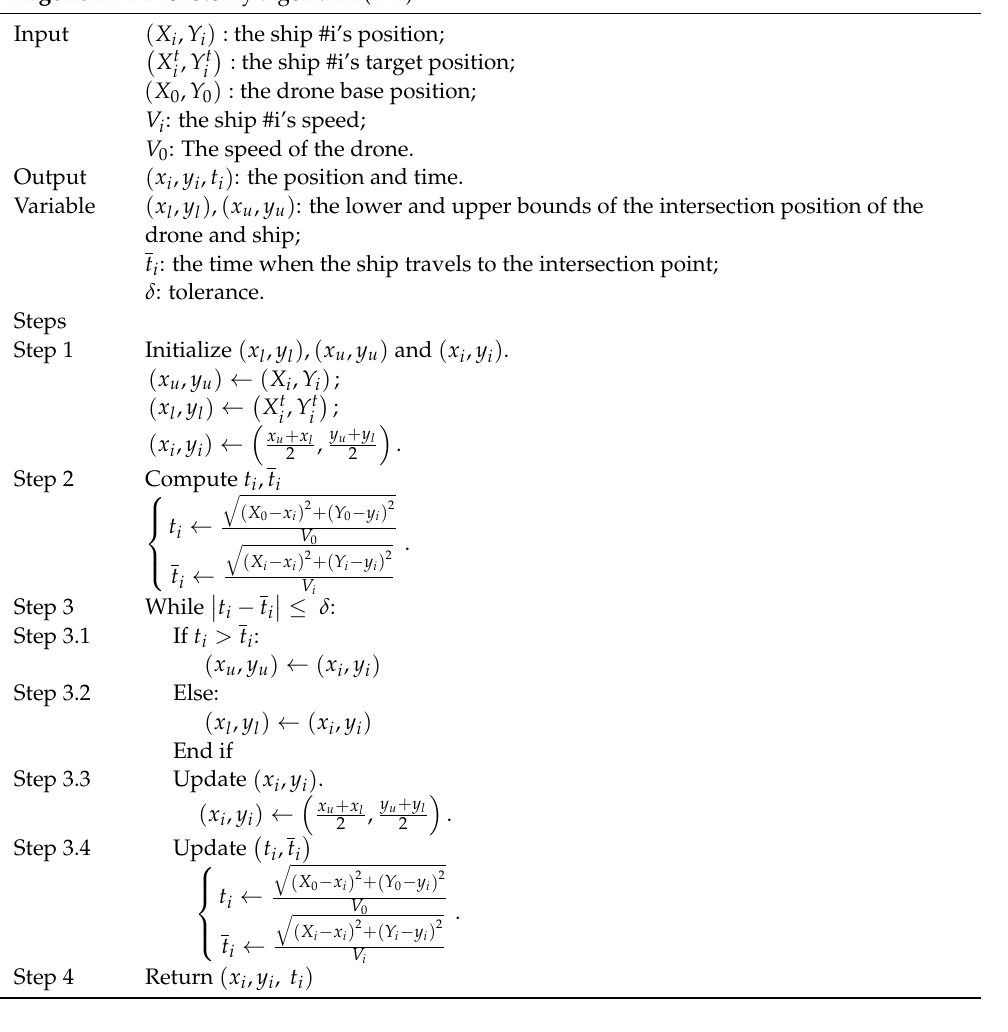
Algorithm 1 Dichotomy algorithm (DA).